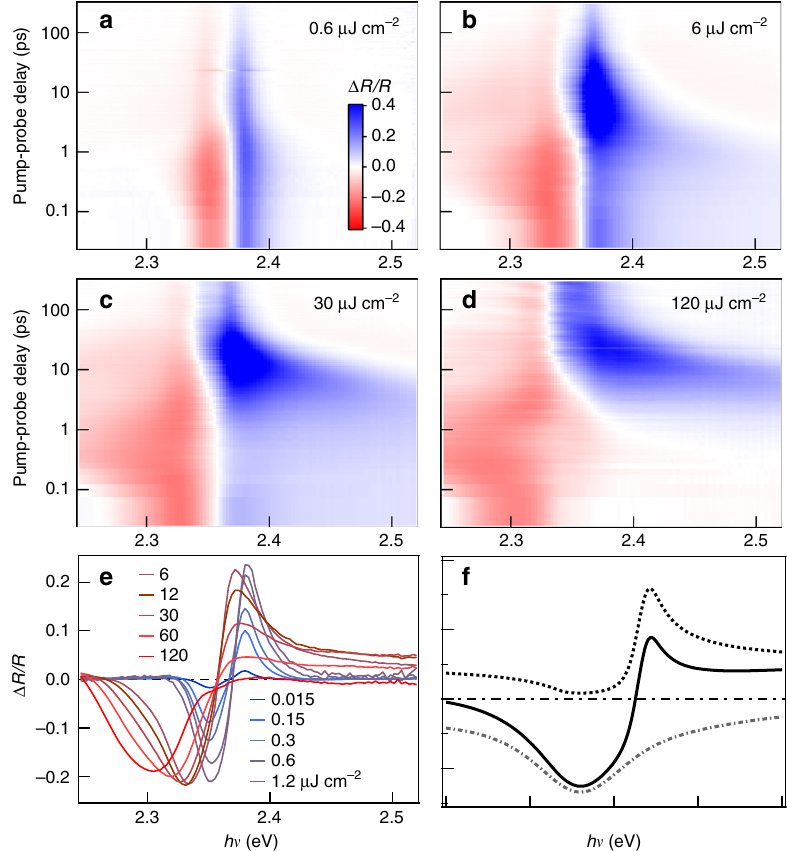
Fig. 4 Transient re fl ectance spectra reveal transitions from excitonic resonance to n-EHP and d-EHP. a – d 2D pseudo-color plots of transient re fl ectance spectra from a CsPbBr 3 single crystal at excitation densities of 0.6, 6, 30, and 120 μ J cm − 2 , respectively. The excitation photon energy was 3.1 eV and the sample temperature was 80 K. e Transients taken at time delay = 50 fs for a variety of pump fl uences spanning the regimes of interest. f Simulated spectral shapes typical of a plasma (dotted curve) and optical gain (dot-dashed curve) and the sum of the two (solid curve); see Supplementary Note 6 for details on spectral